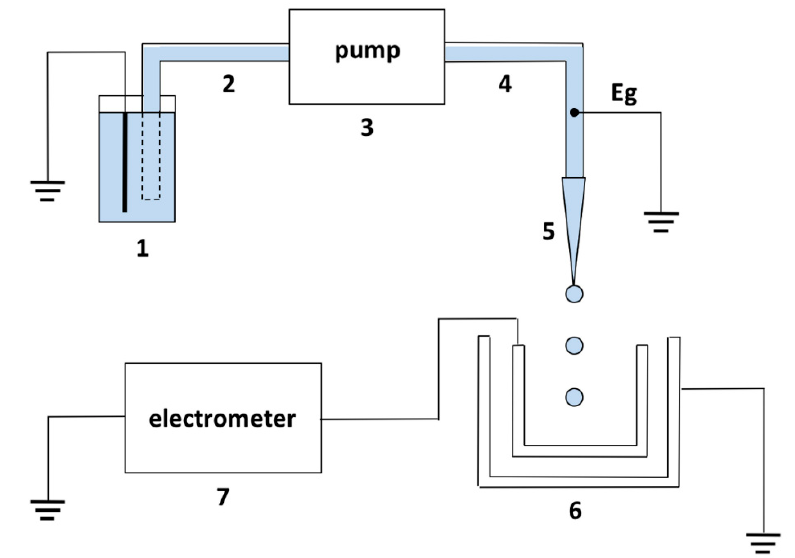
Figure 1. Experimental setup. 1 is the reservoir with water; 2 is the silicone pipe (input section); 3 is the peristaltic pump; 4 is the silicone pipe (output section); 5 is the tip; 6 is the measuring cell with the connected electrometer; 7 is the electrometer; and Eg is the grounding electrode placed at a 15-cm distance from the tip nozzle orifice.